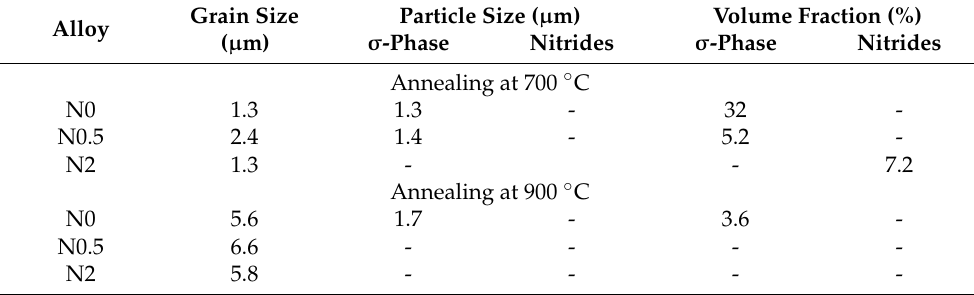
Table 3. Structural parameters (grain size, fraction, and size of secondary phases) of the Fe 40-